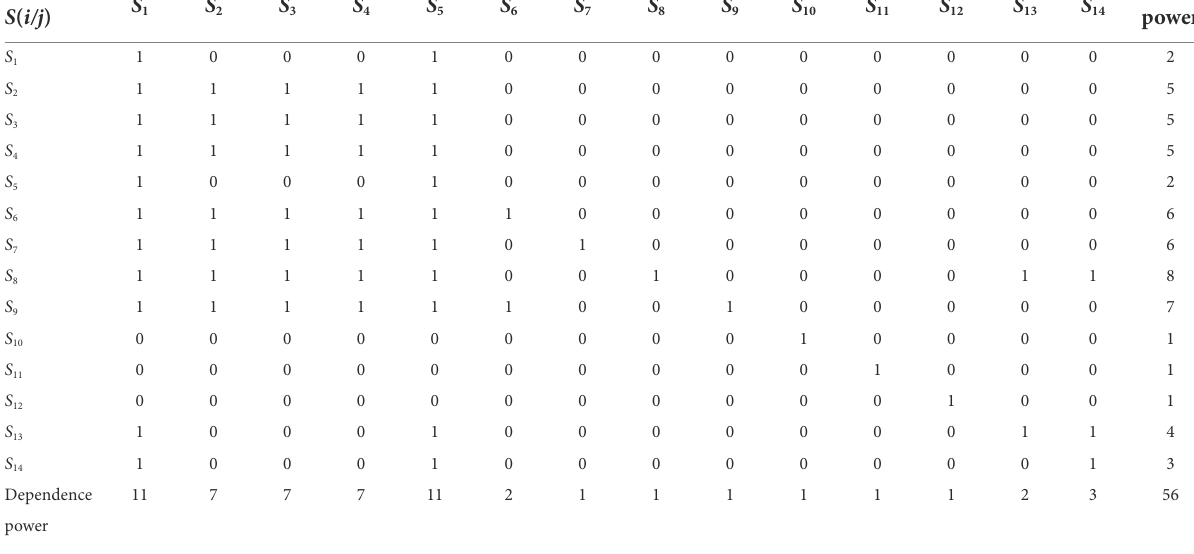
TABLE 4 Reachability matrix of expert performance